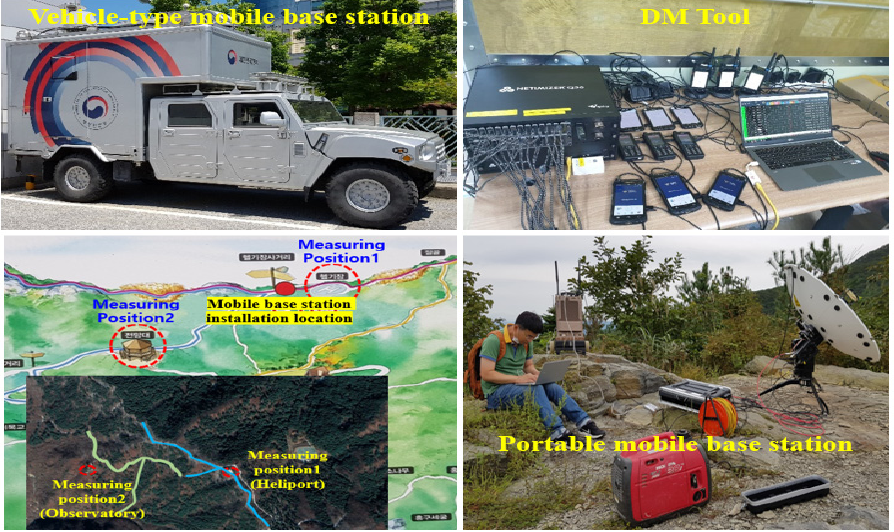
Figure 11. Test environment for mobile base stations.